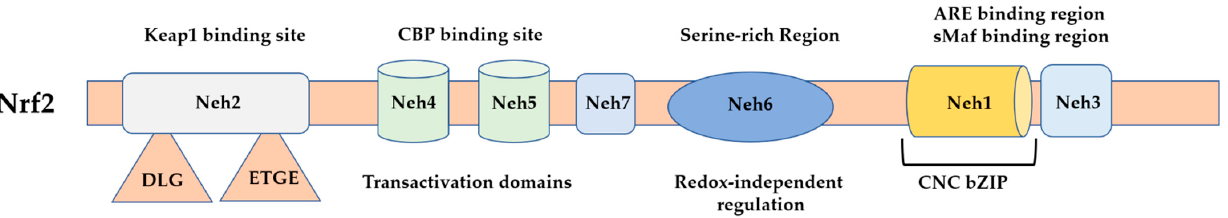
Figure 1. Domain organization of the transcription factor Nrf2. Nrf2 is characterized by seven highly conserved regions, Neh1 to Neh7. Neh1, Neh3, and Neh6 are located at the C-terminus of Nrf2, while Neh2, Neh4, and Neh5 are located in the N-terminal region. Neh1 contains a CNC-bZIP domain responsible for dimerization with small musculoaponeurotic fibrosarcoma (Maf) proteins and required for binding to ARE sequences in DNA. Neh2 domain controls the interaction with the cytoplasmic protein Keap1 via DLG and ETGE motifs. The Neh3 domain is required for the activation of transcription, along with the Neh4 and Neh5 domains that enhance Nrf2-mediated reporter gene transcription in an ATP-dependent manner. Neh4 and Neh5 domains are known as transactivation domains and are involved in the binding to the kinase-inducible domain interacting (KIX) and cysteine/histidine-rich domain 3 (CH3) domains of CBP (CREB (cAMP Responsive Element Binding protein)-binding protein). The Neh6 domain contains a serine-rich conserved region which is involved in degradation of Nrf2. This domain contains two binding sites (DSGIS and DSAPGS motifs) for the β -transducin repeat-containing protein ( β -TrCP). Finally, the Neh7 domain interacts with the retinoic X receptor α , an Nrf2 repressor, and represses Nrf2 target gene transcription.